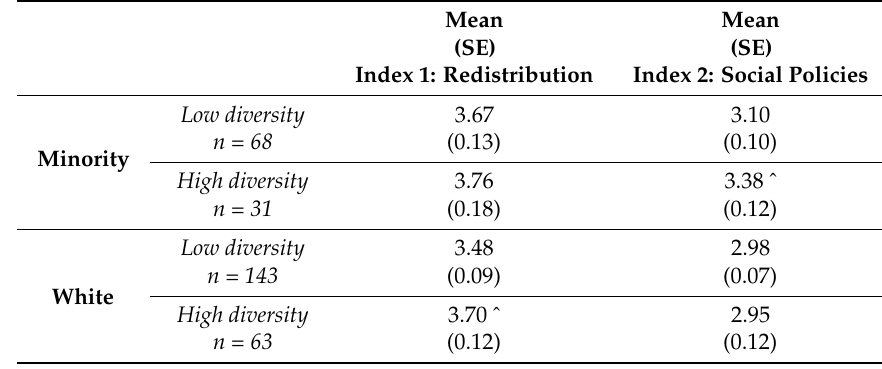
Table 3. Results of independent t -tests of support for redistribution and social policies by perceived neighborhood